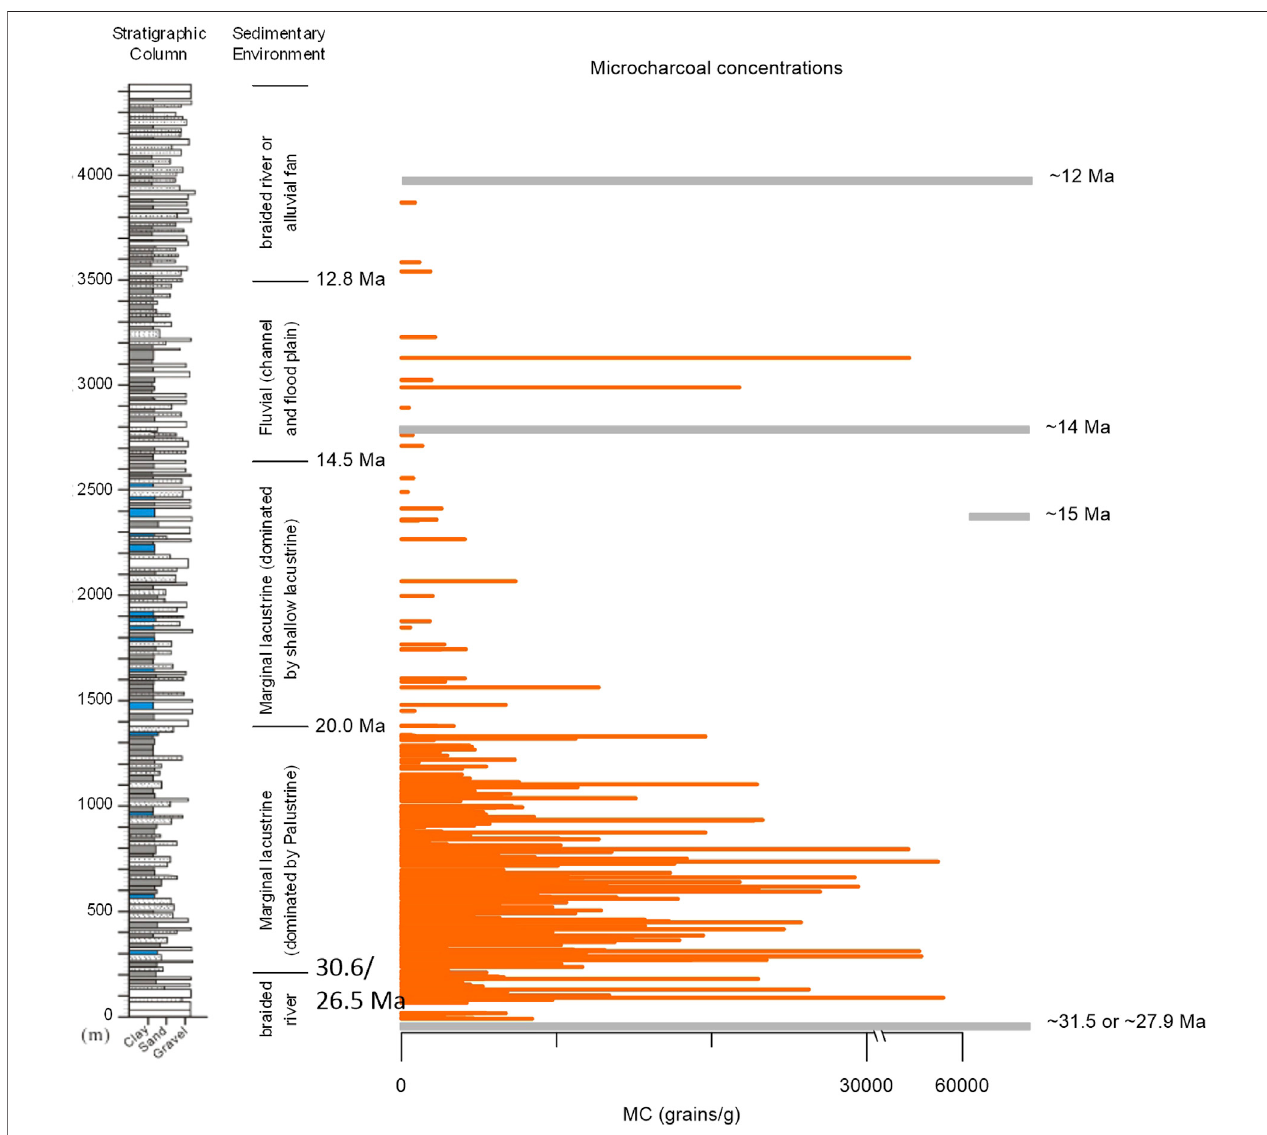
FIGURE 2 | Lithology, sedimentary facies with age between boundary, and microcharcoal results from the HTG section. Age estimates (Chang et al., 2015) and sedimentary facies (Li et al., 2016). MC: total microcharcoal concentrations. Dashed arrows show the dominant MC trends.